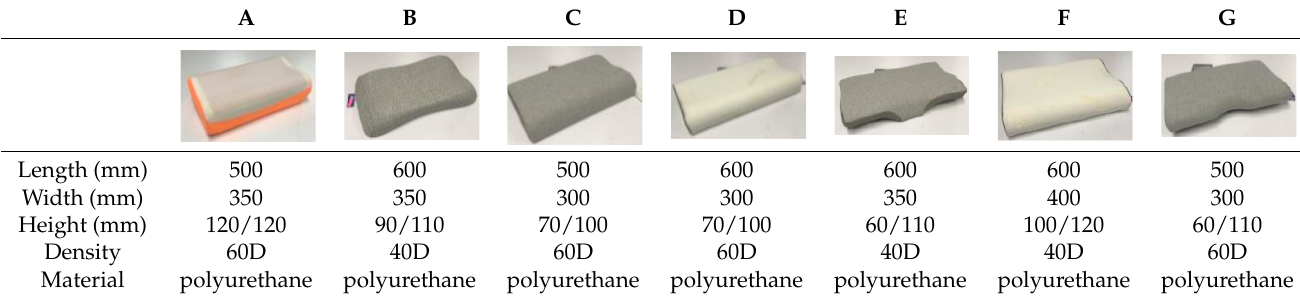
Table 1. Sample parameters of seven types of ergonomic sleep